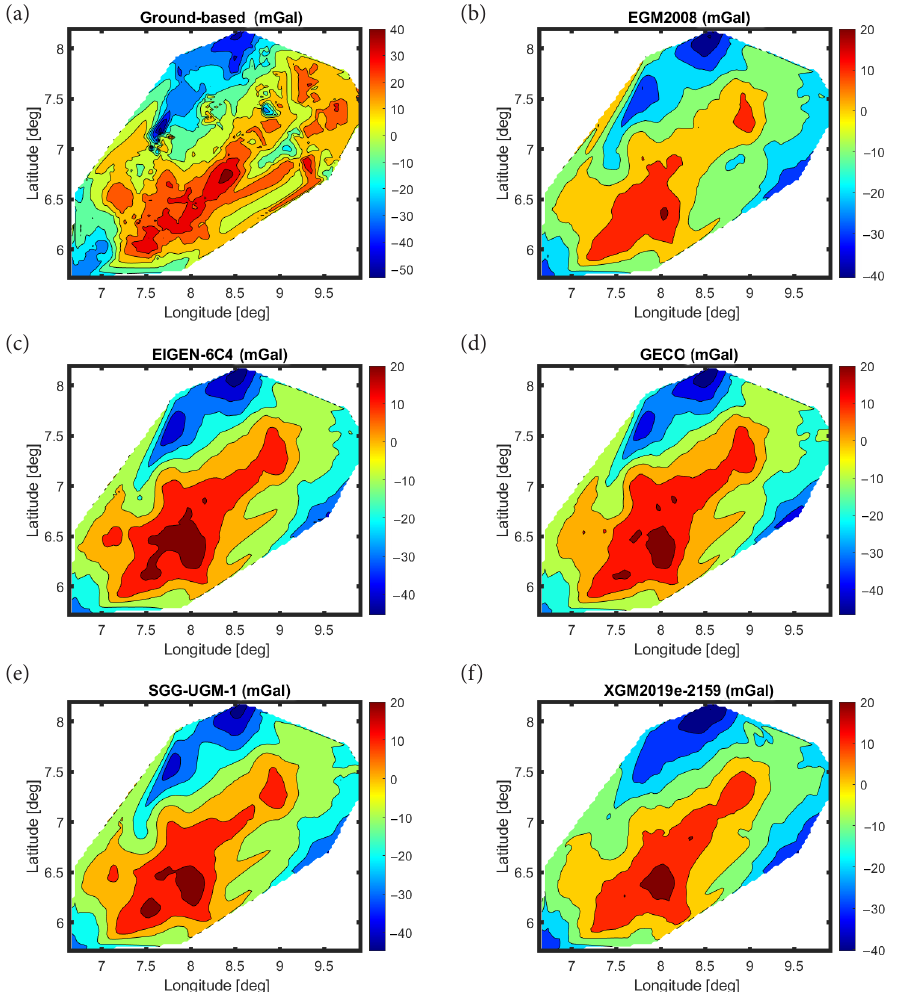
Figure 4. Ground-based versus GGM-derived Bouguer gravity anomalies: a –